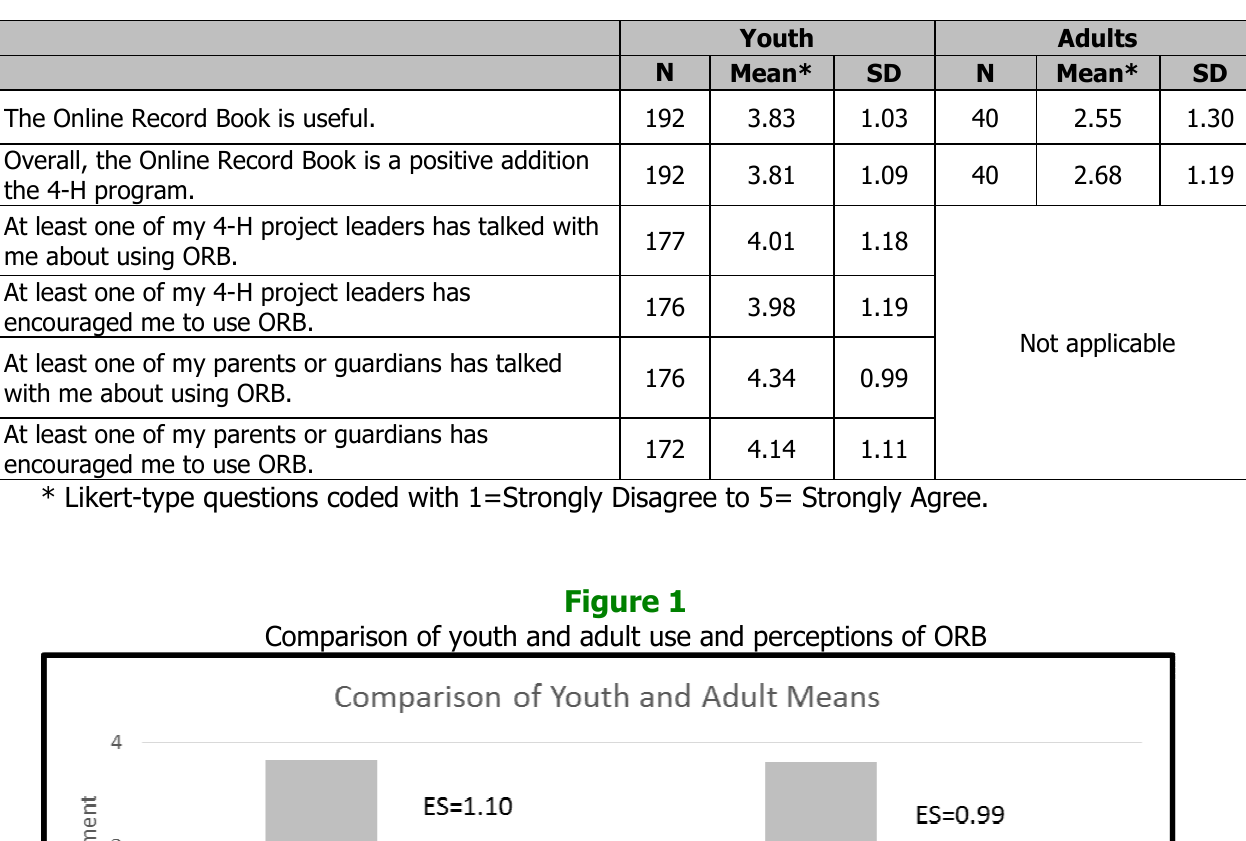
Youth and Adult Perspectives of ORB